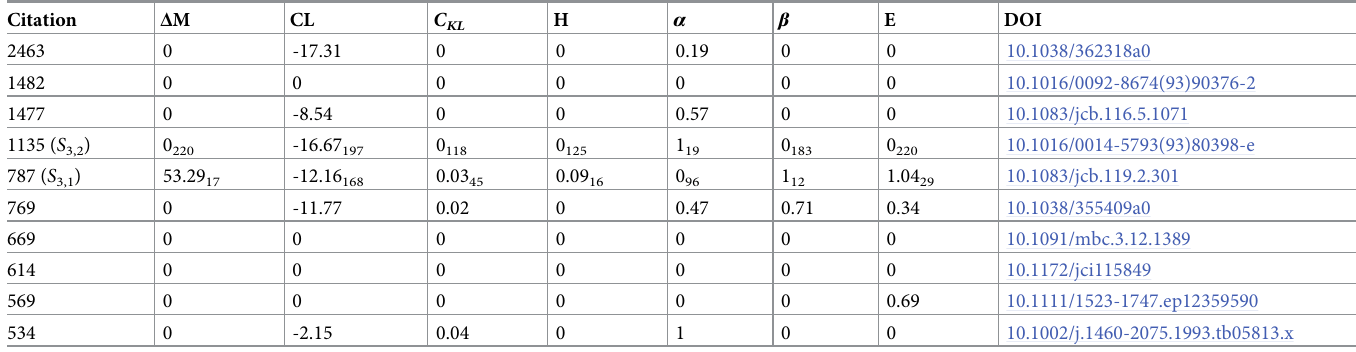
Table 7. Case 3. The SVA scores of the top-10 citing papers in the network (1987-1993). SVA score ranges: Δ M :0.0–80.62, CL :0.0–49.42, C 1.0, β :0.0–1.0, E : 0.0–1.55. The subscript next to an SVA score of each seed paper indicates the paper’s relative rank according to that metric, sorted in a descending order.